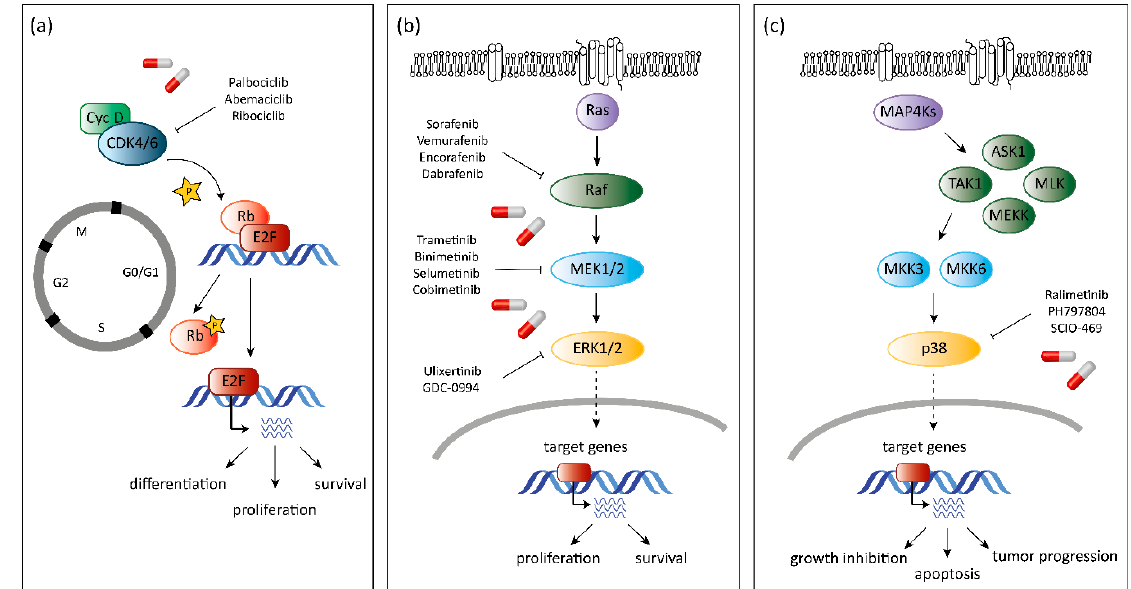
Figure 3. Overview of CDK4/6 and MAPK inhibitors. ( a ) FDA approved small-molecule inhibitors palbociclib, abemaciclib and ribociclib bind to CDK4/6 and prevent phosphorylation of Rb (indicated by the star symbol), which can result in cell cycle arrest in the G1 phase, block of differentiation and survival. ( b ) Inhibitors of the ERK pathway blocking the prosurvival and proliferative effects of ERK signaling. ( c ) Inhibitors of p38 are controversial and can have opposing effects as p38 is a tumor suppressor but can also have tumor promoting effects at later stages of cancer development. “T-lines” indicate inhibition, arrows indicate activation and dashed arrows indicate translocation into the nucleus. The arrows at the bottom of each panel show major outcomes of the signaling networks.